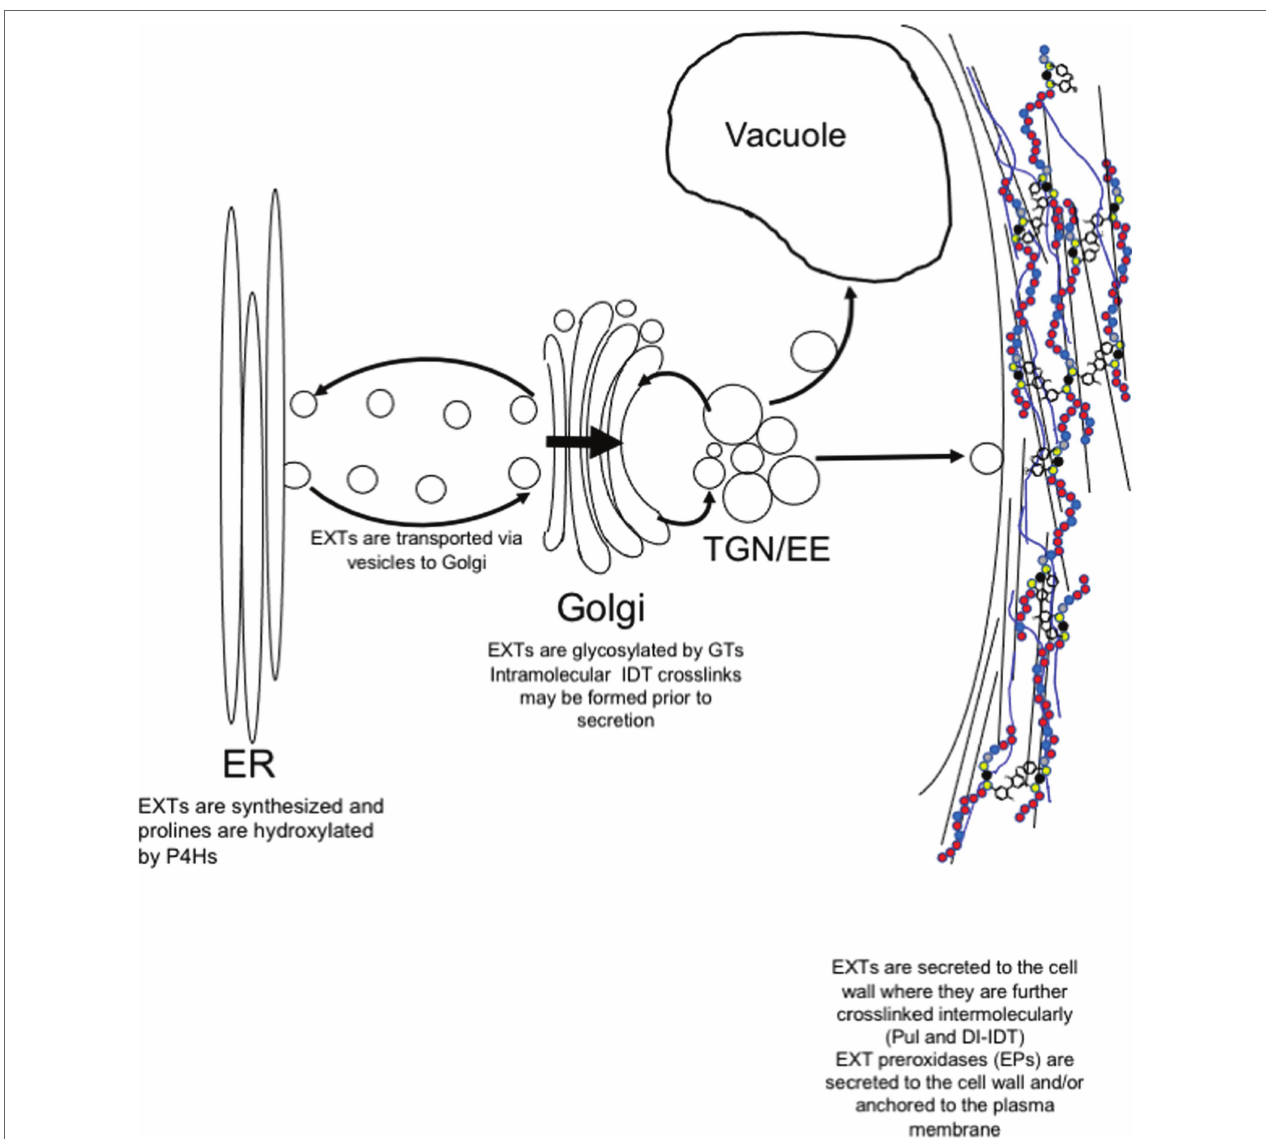
FIGURE 2 | Post-translational modification and secretion of EXTs. EXTs are synthesized in the endoplasmic reticulum (ER) and post-translationally modified by prolyl 4-hydroxylases (P4Hs). In the Golgi, EXTs are further modified by Hyp- O -arabinosylation and Ser- O -galactosylation. EXTs are sorted in trans-Golgi network (TGN) for secretion to the plasma membrane. Somewhere between the TGN and the cell wall, intramolecular IDT crosslinks are formed before release to the cell wall where they self-associate to form the EXT network. EXT monomers can become covalently crosslinked by extensin peroxidases (EPs). EPs use extracellular hydrogen peroxide to form covalent intermolecular crosslinks, such as Pul and di-IDT, which covalently lock EXTs within the cell